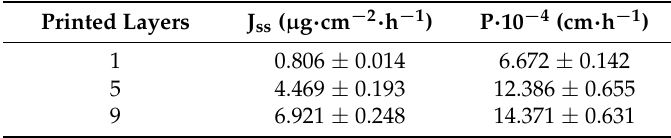
Table 4. Permeation parameters for multiple printed films.